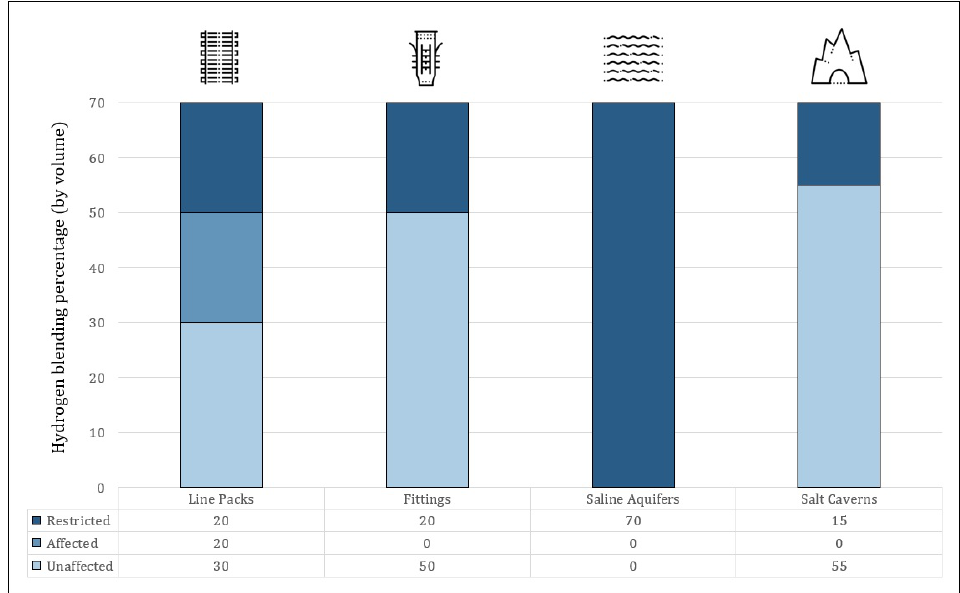
Figure 8. Susceptibility of P2G storage options to different volume fractions of hydrogen